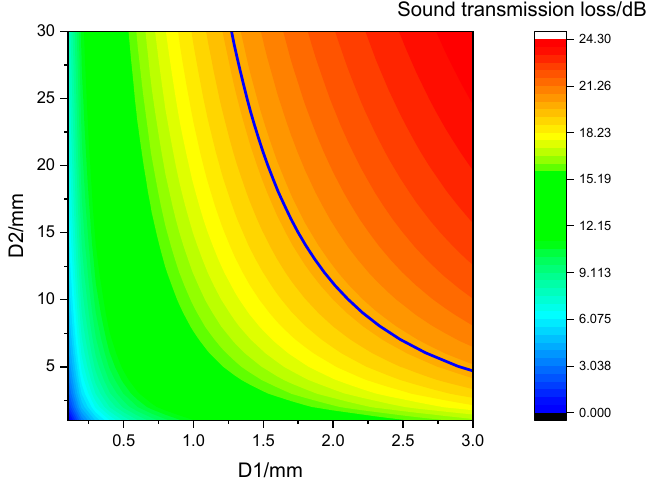
Figure 7. Parameter combinations meeting the sound insulation conditions (2D plot).